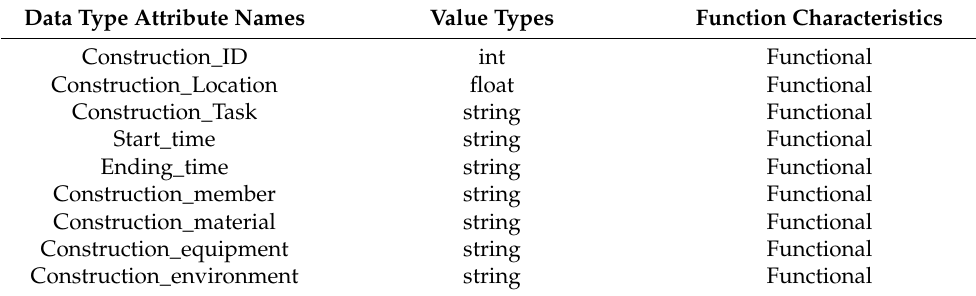
Table 4. Construction activity data type attribute definition.